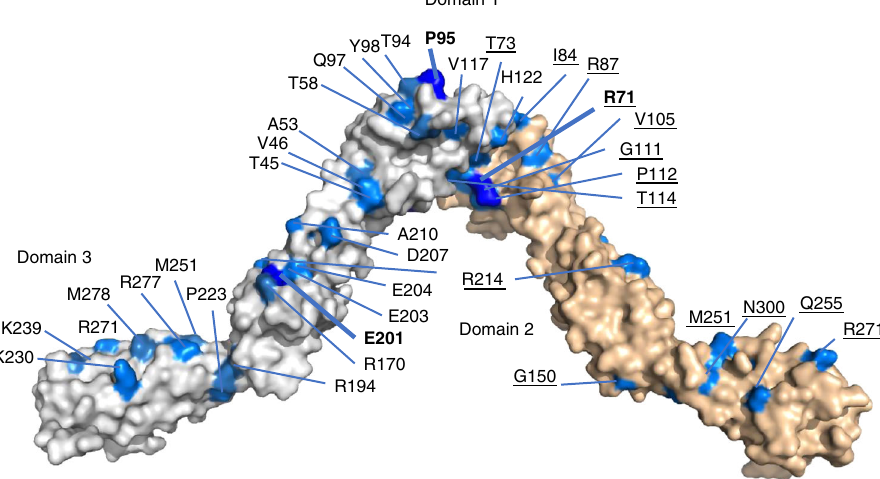
Fig. 2 Mapping of the most common mutations on to the OPCML crystal structure homodimer. The OPCML homodimer is shown in space- fi lling representation with one monomer in white and the other wheat. Mutations associated with the wheat monomer are underlined. Mutations in domains 1 and 3 are drawn on the outside of the dimer, whilst domain 2 associated mutations are shown on the inside. The most commonly mutated sites (sites mutated 8 or 9 times) are shown in blue with the residue name in bold. Residues mutated 4, 5 or 6 times are shown in marine and residues mutated 3 times shown in sky blue. For simplicity, mutations found 1 or 2 times are not highlighted, with the exception of